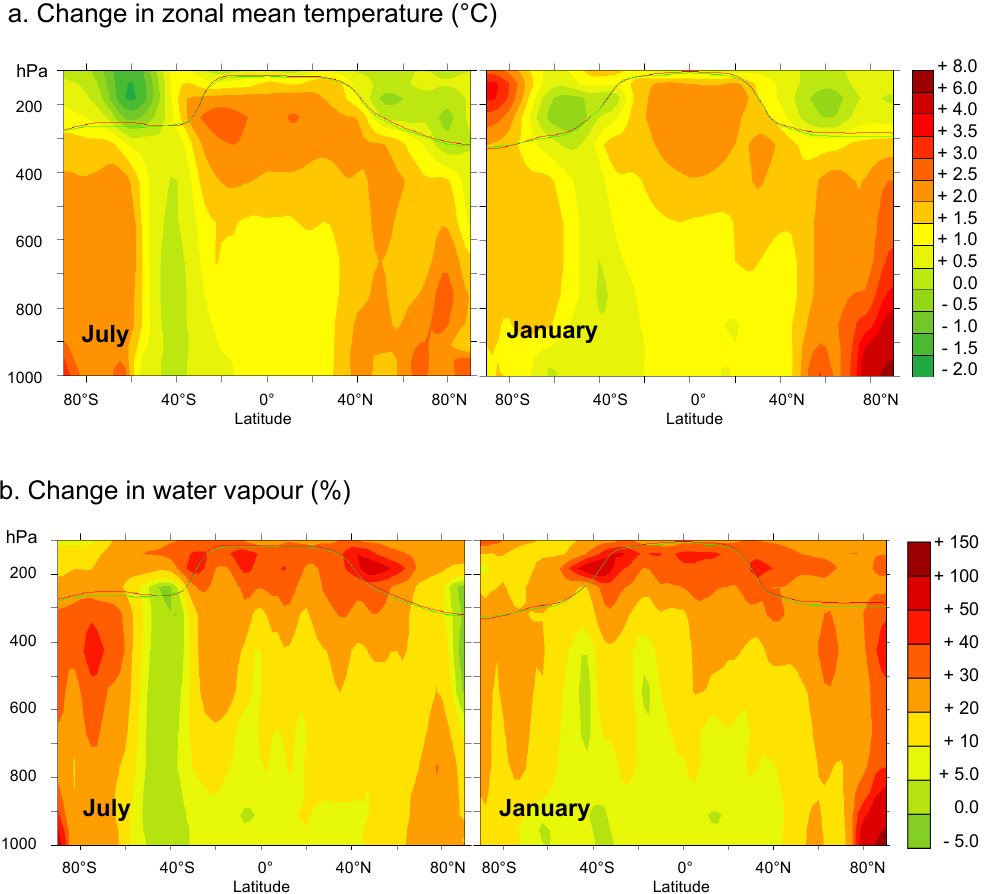
Fig. 8. Future (2050) change in zonal mean temperature (degrees) and water vapour (%), for July (left) and January (right) conditions (A1B emission